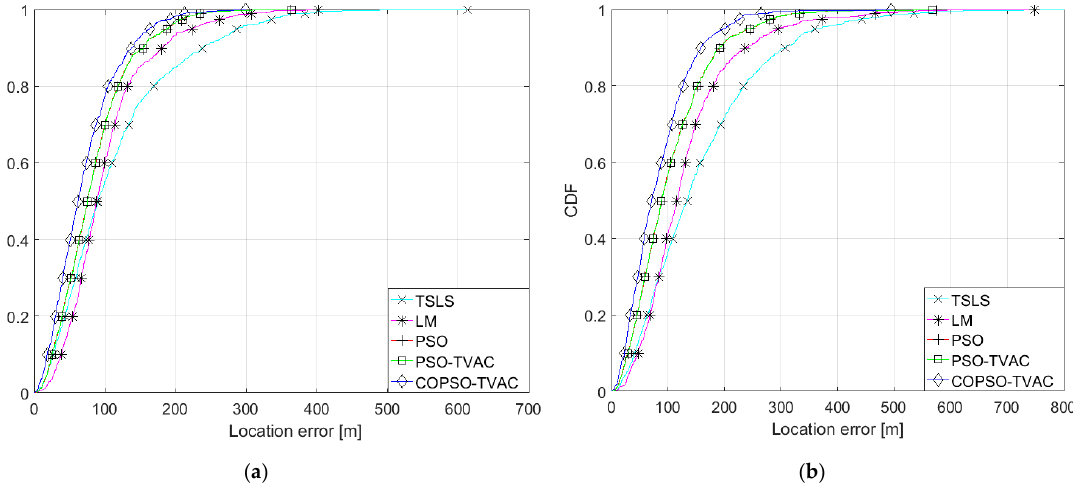
Figure 7. CDF of the location error in the scenario with 4 NLOS BSs: ( a ) the suburban environment; ( b ) the urban environment. Compared with the existing methods (the TSLS [13], the LM [7], and the TRR [8]), the accuracy of the MS location indeed improved with the proposed metaheuristic algo ‐ rithms. In all NLOS conditions, the PSO algorithm [22] and the PSO ‐ TVAC algorithm [36] produce very similar and very good results, with the COPSO ‐ TVAC algorithm being bet ‐ ter than both. In the case when two NLOS BSs participate, all algorithms except the TSLS algorithm give expected results, which are more or less similar and very close to the RAMMSE . The power of the COPSO ‐ TVAC algorithm is shown in the simulations with three and four NLOS BSs, where it greatly surpasses all other algorithms regardless of the type of environment. It is interesting to note that metaheuristic algorithms give better results than RAMMSE for the scenarios with three and four NLOS BSs, as shown in Tables 2 and 3. Namely, as the number of NLOS BSs increases, the nonlinearity of the objective function (13) greatly increases. In this way, the ML estimator becomes more biased, which is the possible reason for obtaining such results [53]. A similar case where the MSE takes lower values than the CRLB can be found in Reference [54]. This fact does not diminish the sta ‐ tistical weight of the RAMMSE metric and does not mask the quality of the obtained re ‐ sults. 5.2. Convergence Properties The convergence characteristics show the change in the average fitness function dur ‐ ing algorithm execution. It makes sense to compare these characteristics from the first it ‐ eration (for the same ML fitness function (13)). The convergence properties of the given metaheuristic algorithms across environments for all scenarios are shown in Figures 8–10. Note that the mean of the best fitness is dimensionless, and that the penalty functions are included in it.